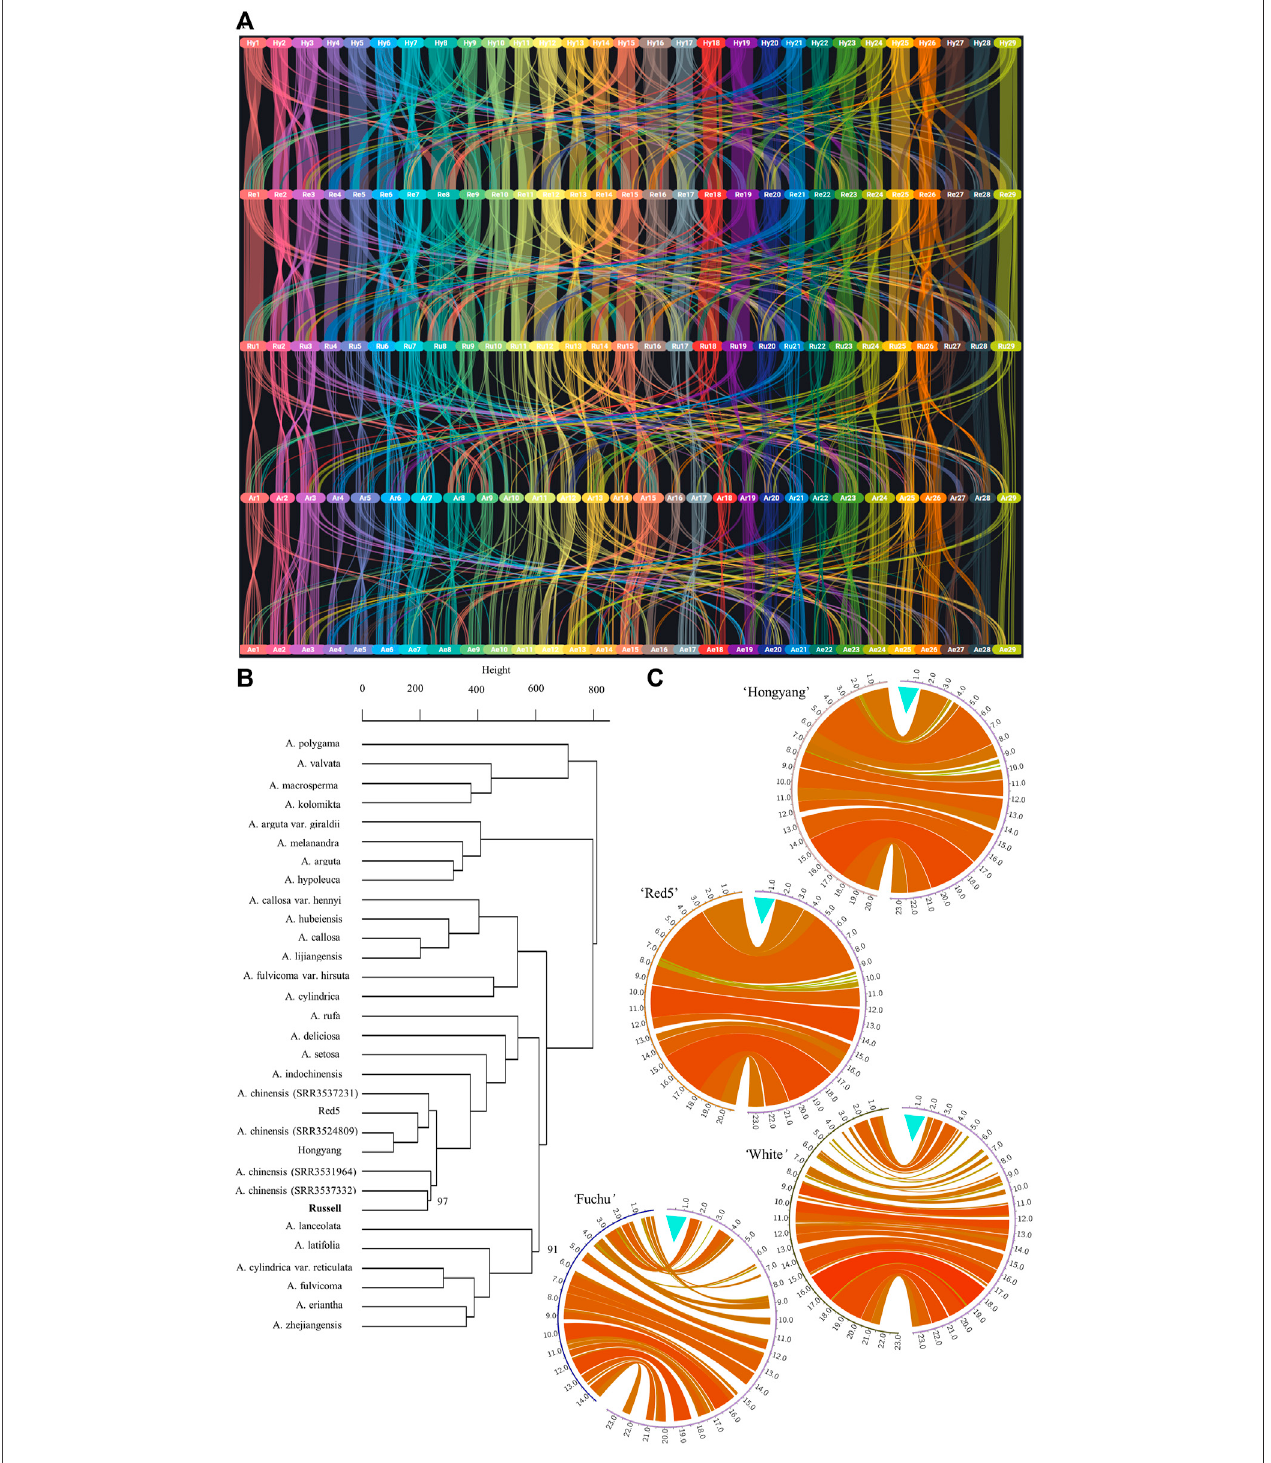
FIGURE 1 | Comparison of the ‘ Russell ’ genome with other Actinidia genomes. (A) shows synteny for protein-encoding genes, across the genomes, as they are anchored on respective chromosomes 1-29 in the form of blocks. The synteny as well as inter-chromosomal homology or duplication events, described by co-linearity metrics drawn from BLASTP and MCScanX, for protein-encoding genes. The genomes are in the following order from top to bottom: A. chinensis ‘ Hongyang ’ (v3), A. chinensis Red5 (v2), A. chinensis ‘ Russell ’ , A. rufa ‘ Fuchu ’ and A. eriantha ‘ White ’ . Two letter codes were applied as follows: Hy —‘ Hongyang ’ , Re — Red5, Ru —‘ Russell ’ , Ar — A. rufa and Ae — A. eriantha . ‘ Hongyang ’ chromosome assemblies were renamed to conform to the linkage group numbers used across the other